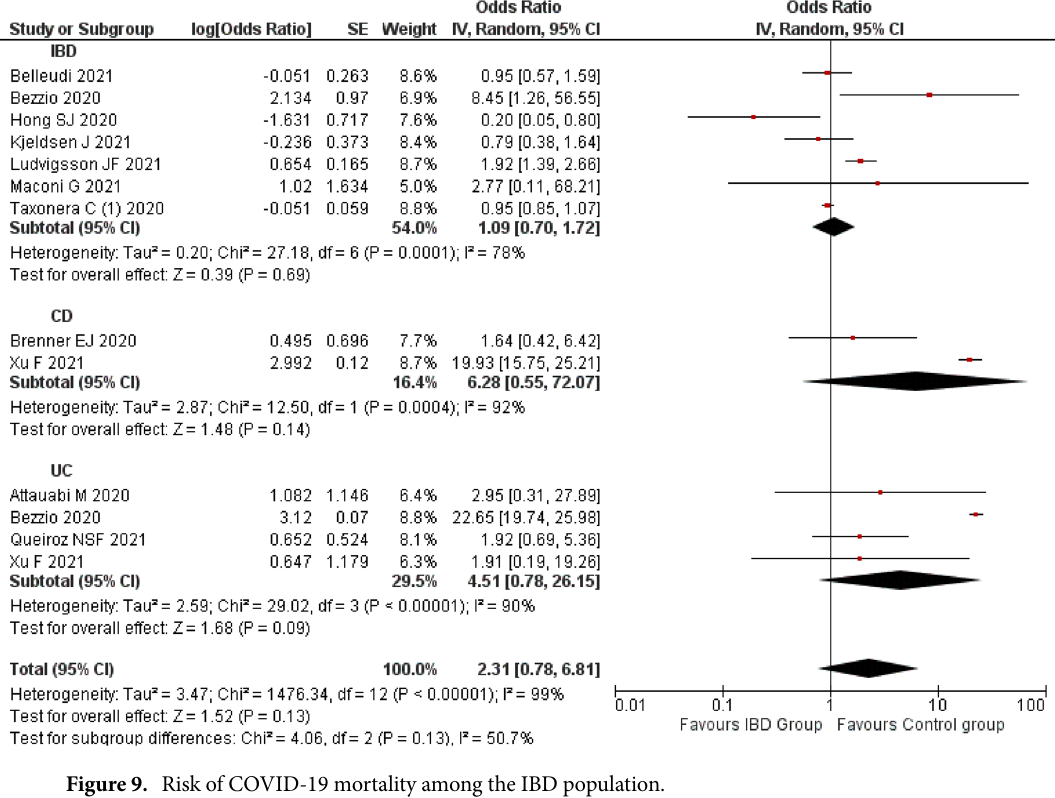
Figure 9. Risk of COVID-19 mortality among the IBD population.